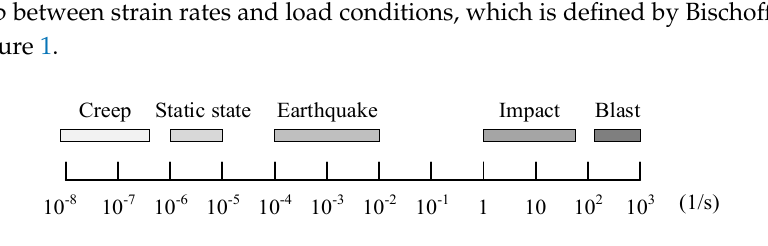
Figure 1. The strain rates in different kinds of loads.